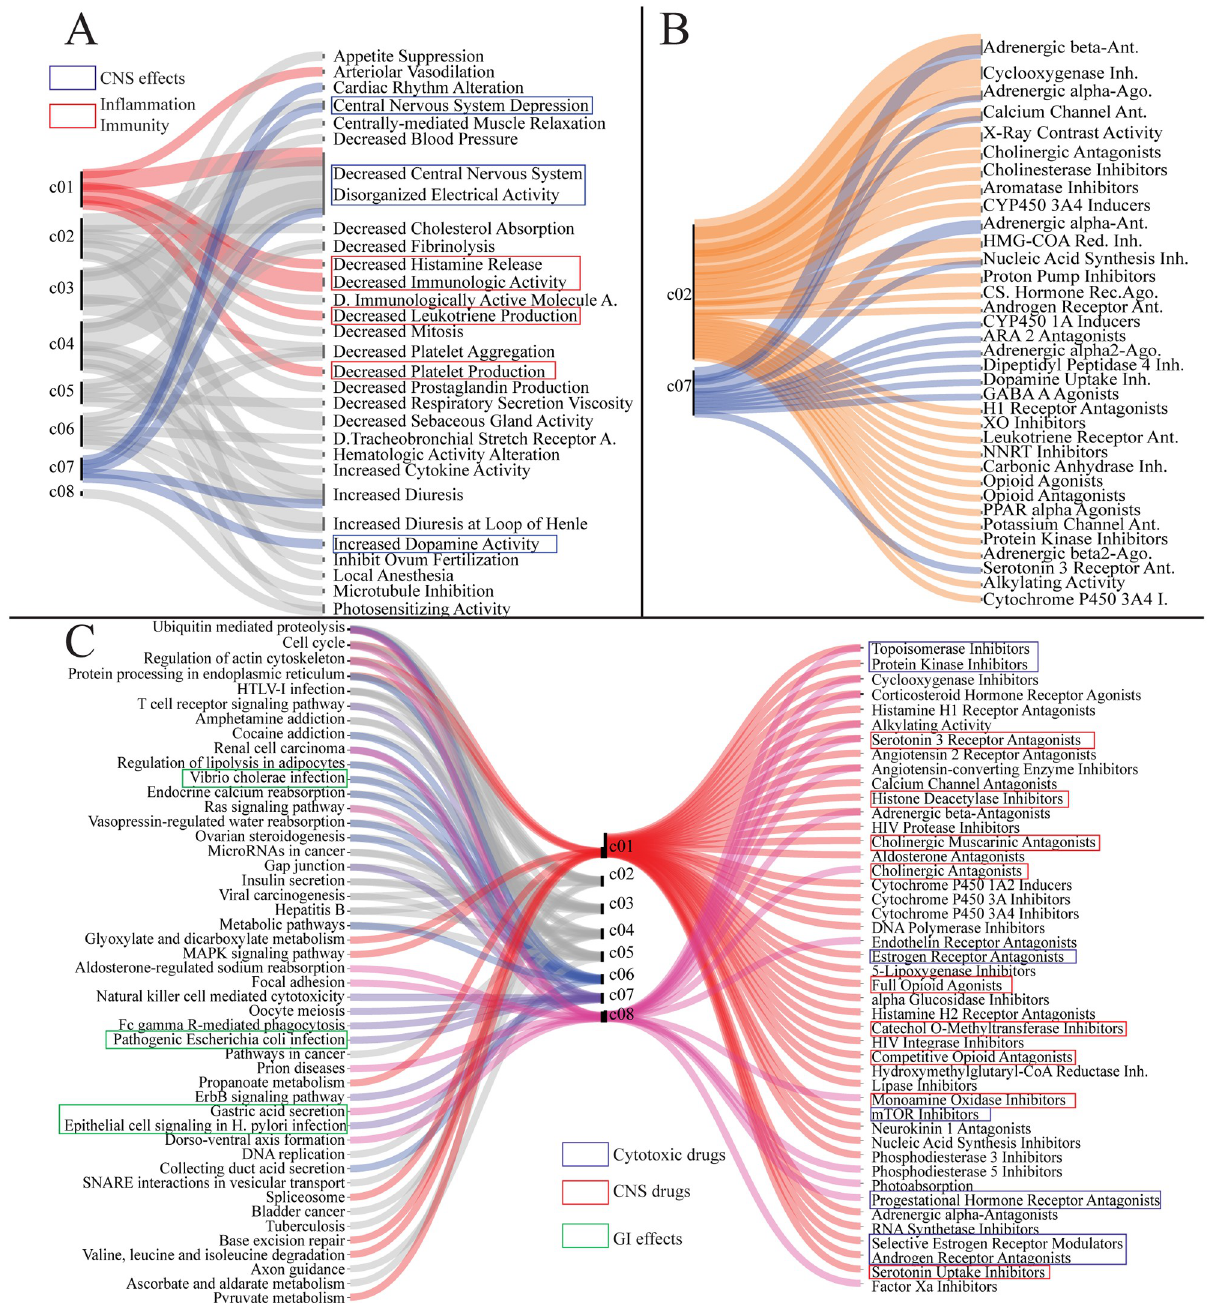
Fig 5. Cluster annotation using FDA NDCD and KEGG databases. A-Bipartite graph of the drug clusters and FDA NDCD PE linking each cluster to reported physiological effects of drugs. B-Bipartite graph of the drug clusters and FDA NDCD EPC linking the clusters to the reported pharmacological class. C-Graph linking the drug clusters to the FDA NDCD MoA and KEGG-enriched pathways of the gene pertaining to each cluster. The graph links the drug mechanism of action to the pathways perturbed by the drug.